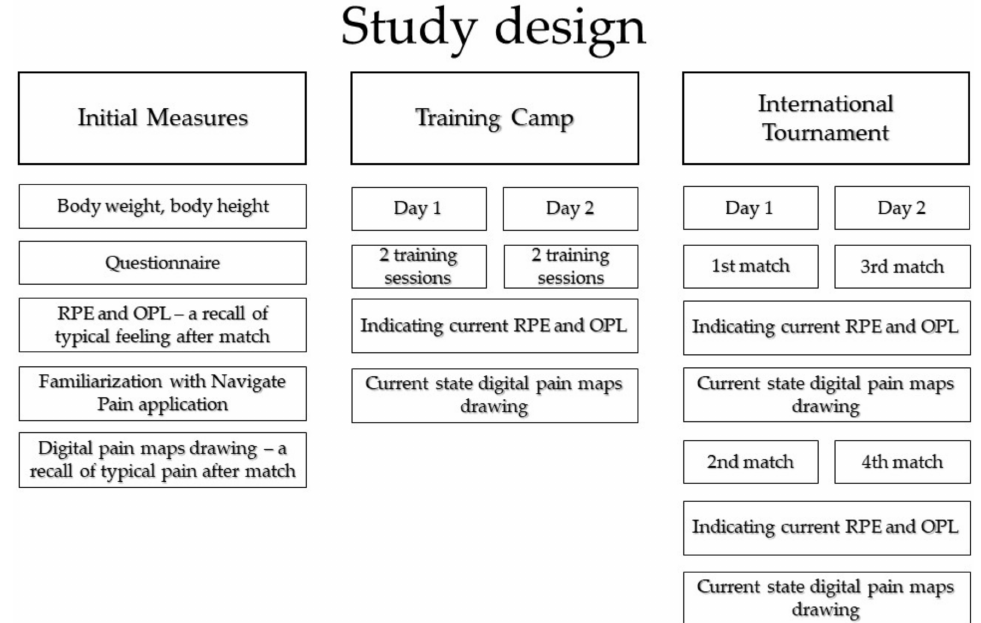
Figure 1. The study design. OPL = Overall Pain Level, RPE = Rate of Perceived